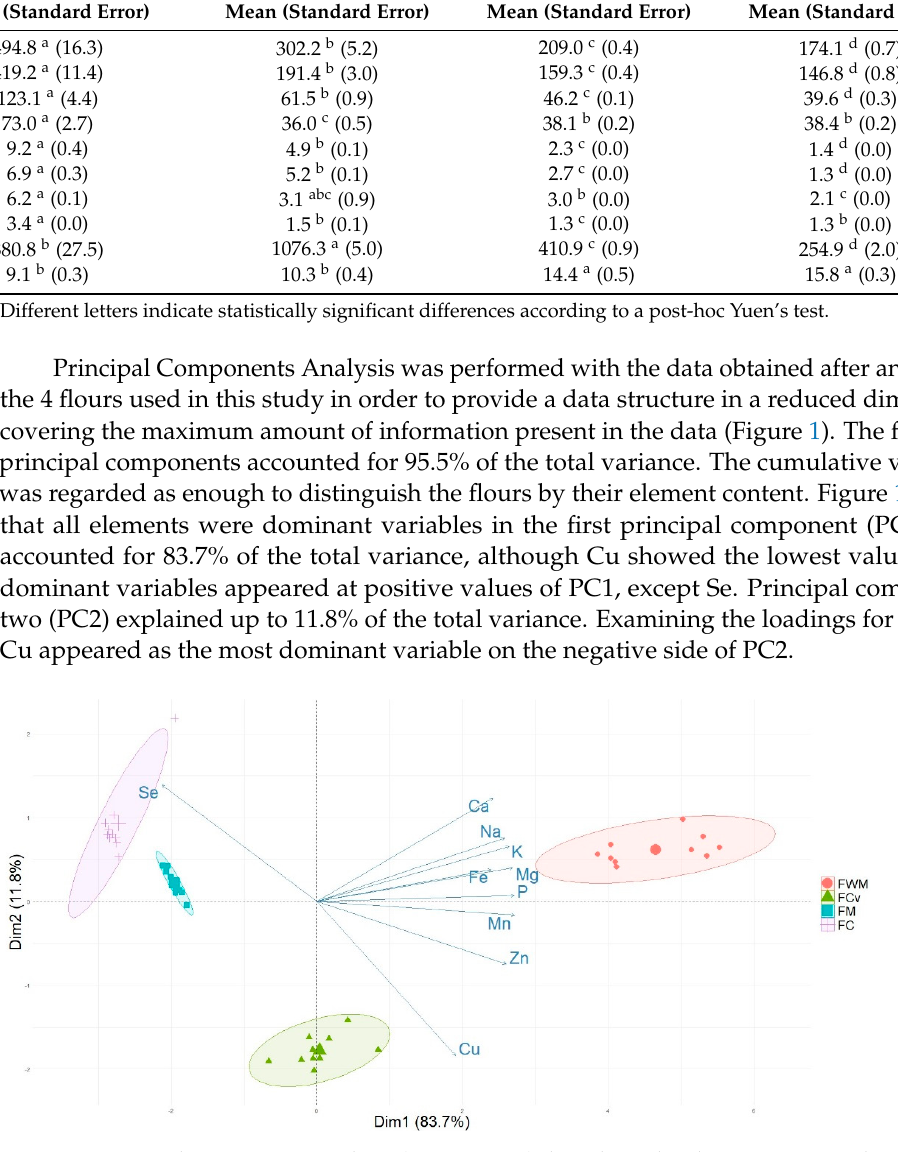
Figure 1. Principal components analysis (PC1 vs. PC2) describing the element variation between the flours and 90% confidence ellipses. FC: 100% refined Castilla variety; FCv: 100% refined ‘Caaveiro’ va- riety; FM: 75% FC + 25% FCv refined mixed flour: FWM: 75% FC + 25% FCv wholemeal mixed